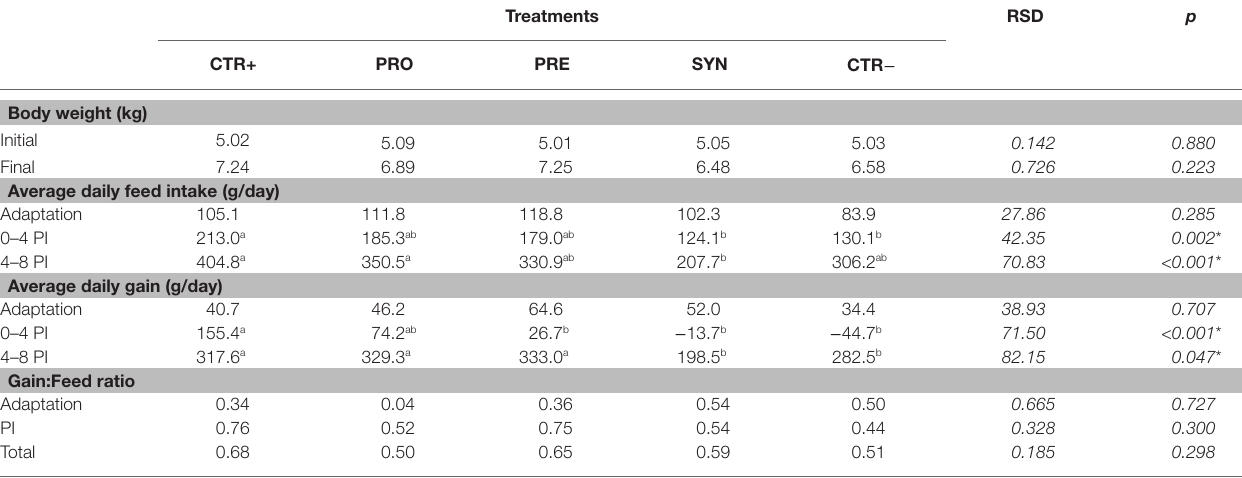
TABLE 3 | Effects of experimental treatments on feed intake and weight gain.